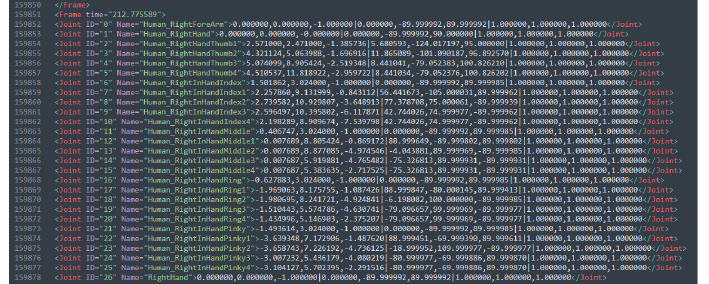
Figure 12. Standard-action data display.